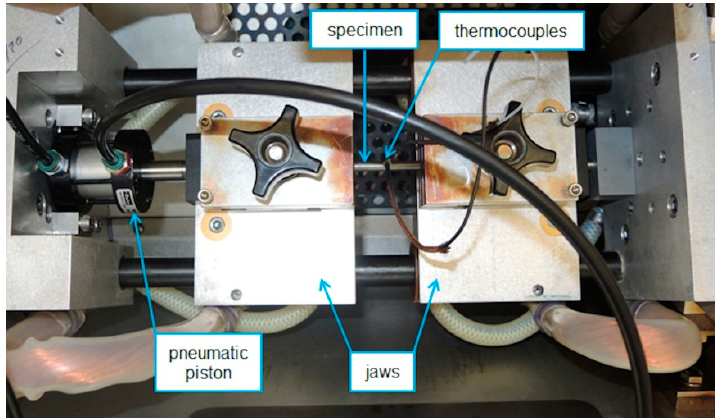
Figure 1. Photograph of a specimen fixed between special jaws with pneumatic pistons for the determination of nil-strength temperature in the plastometer Gleeble 3800.